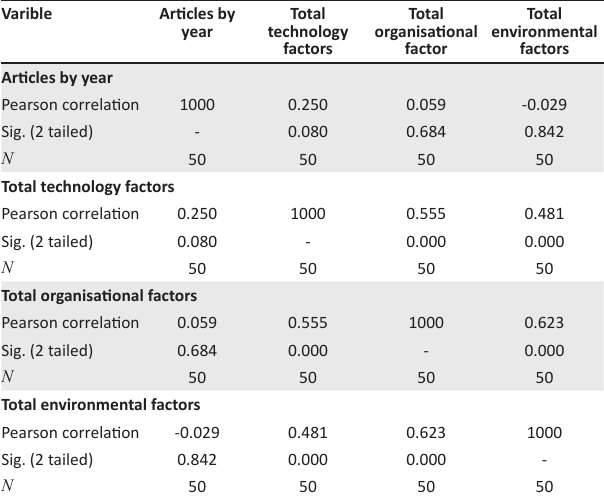
TABLE 3: Correlation of technology-organisational-environmental factors. Varible Articles by